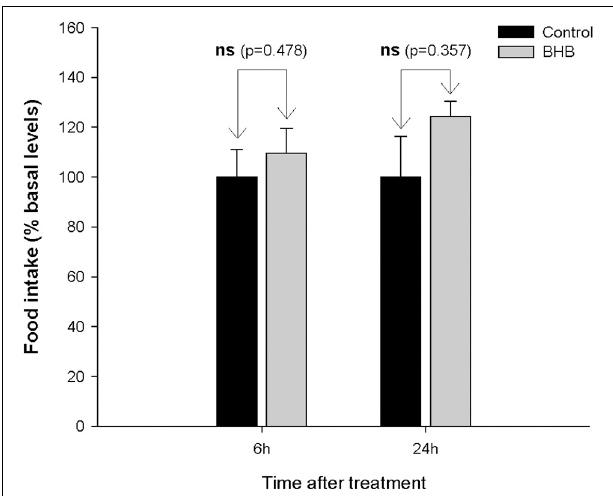
FIGURE 1 | Food intake in rainbow trout 6 and 24 h after intracerebroventricular administration of 1 µ L 100 g – 1 body mass of saline solution alone (Control) or containing 0.5 µ mol of β -hydroxybutyrate (BHB). Food intake is displayed as the percentage of food ingested with respect to baseline levels (calculated as the average of food intake the 3 days previous to experiment) and was normalized to control group (100%). Each value of food intake is the mean ± SEM of 3 experiments ( N = 3) with n = 10 fish per treatment in each tank per experiment. ns, not significant difference.